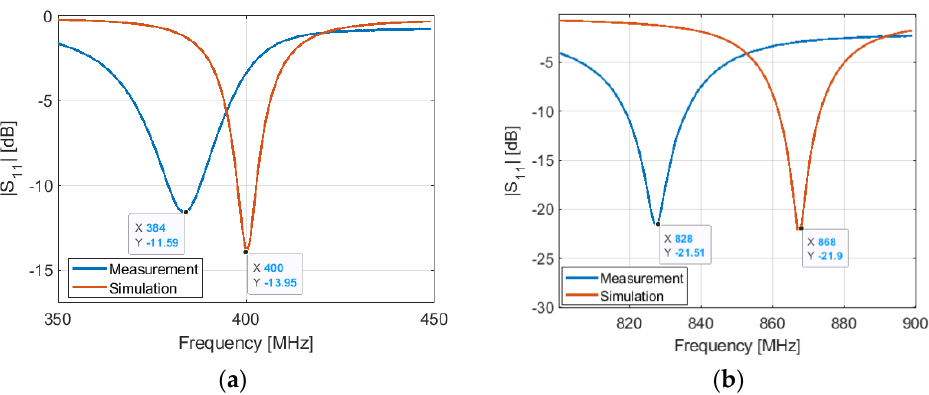
Figure 12. Simulated and measured S11 of the antenna in OFF configuration: ( a ) at 401 MHz ; ( b ) at 868 MHz.